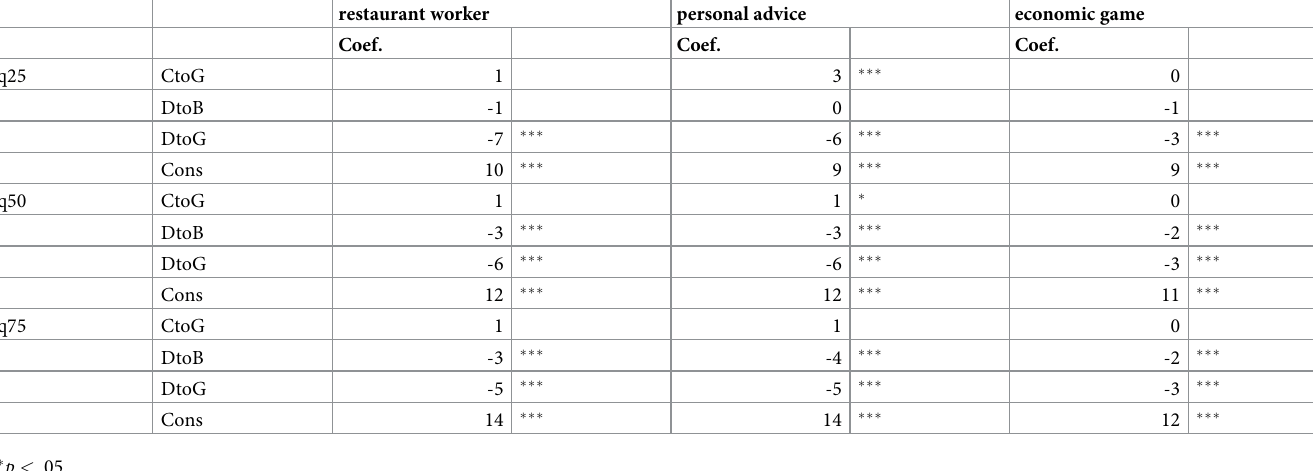
Table 1. Results of quantile regression: CtoB was the baseline category. We used “sqreg” command in Stata var.15 with a bootstrap method repeated 400 times.